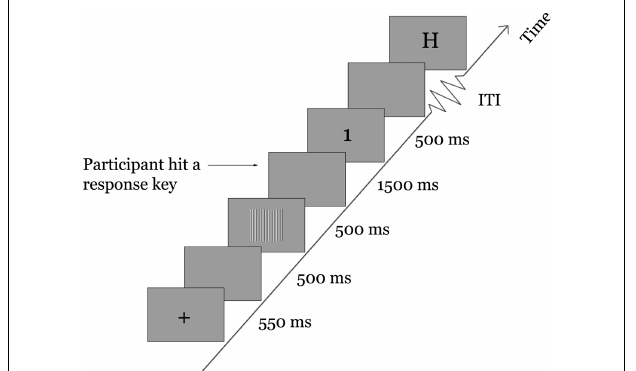
FIGURE 3 | Mean identifi cation accuracy for low-contrast gratings. Bars indicate standard errors of the